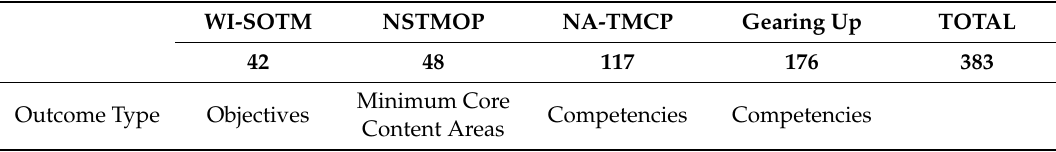
Table 1. Summarization of Learning Outcomes by Program and